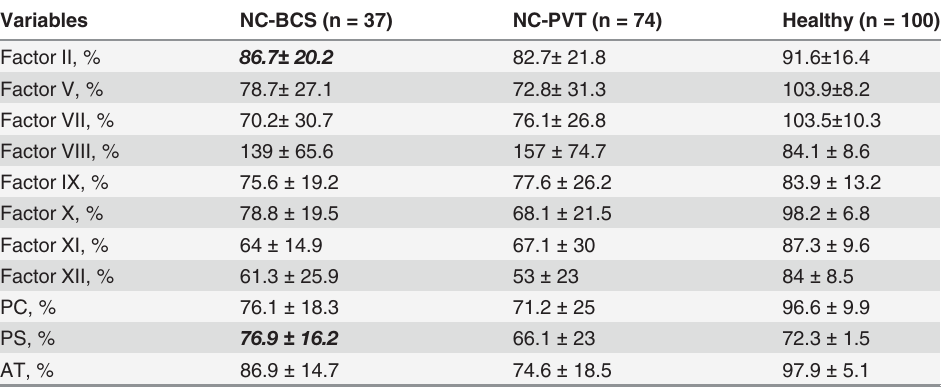
AT, % NOTE. Values are expressed as mean ± SD. Bold Italic value indicates P > 0.05 when compared with the control